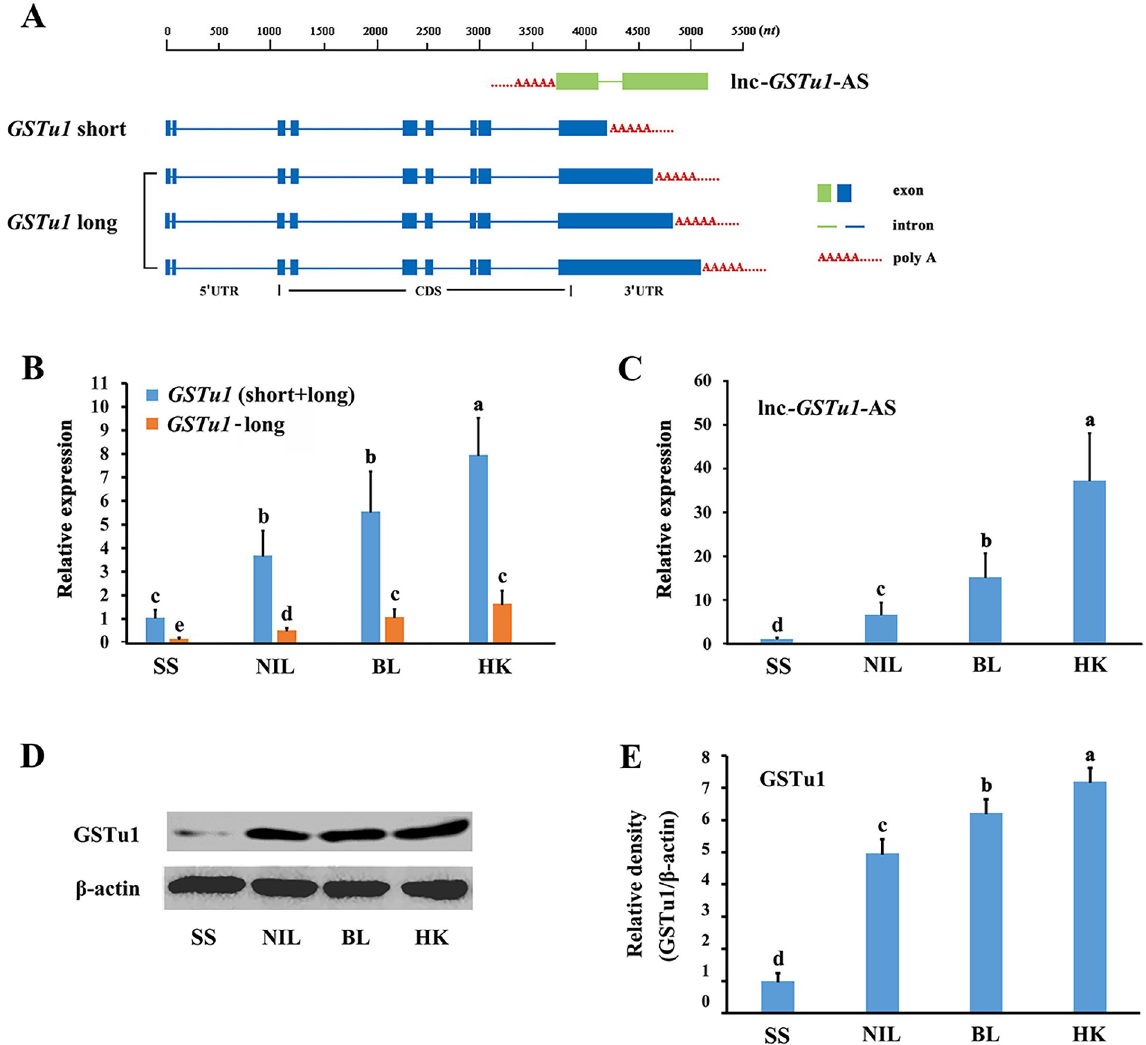
Fig 1. Structure and location of GSTu1 and lnc- GSTu1 -AS and their relative expression in susceptible and three chlorantraniliprole- resistant populations. A: The structure and location of full-length GSTu1 and lnc- GSTu1 -AS. Relative expression of GSTu1 in a susceptible population (SS) and three chlorantraniliprole-resistant populations (NIL, BL and HK) by qRT-PCR (B) and Western blotting (D, E). C: Relative expression of lnc- GSTu1 -AS in a susceptible population (SS) and three chlorantraniliprole-resistant populations (NIL, BL and HK) by qRT-PCR. Different lowercase letters represent significant differences (one-way ANOVA followed by Tukey’s multiple comparison tests, P <